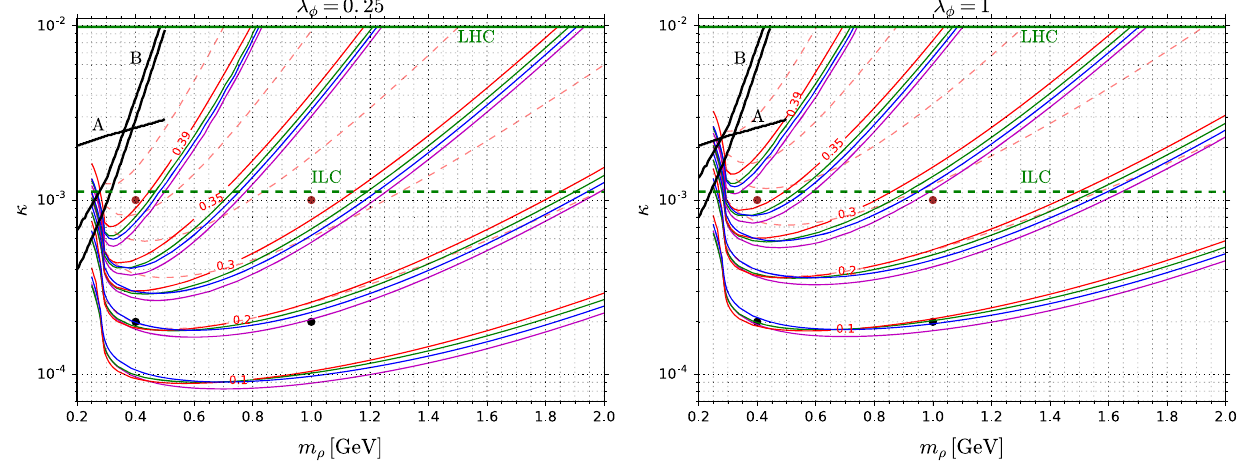
Fig. 3 As top panels in Fig. 1 but for solutions of the Boltzmann equation with and without approximations defined in Sect. 2.1. Colors for continuous lines are described in Fig. 2. Red dashed lines correspond to calculation with the pions contribution